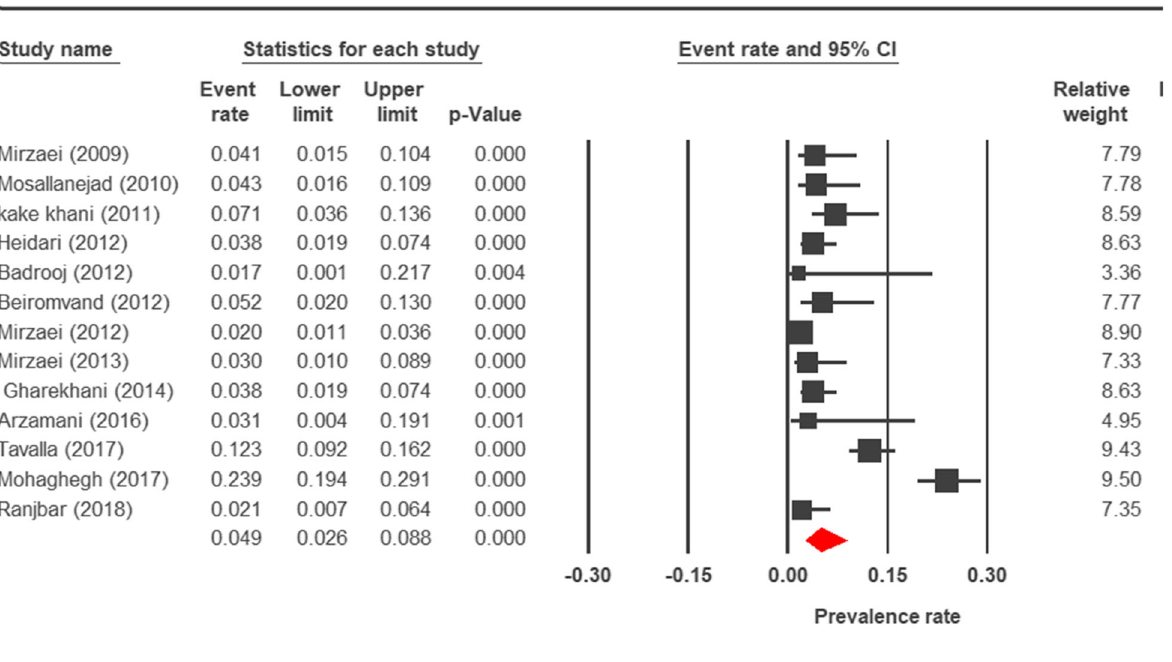
Fig. 6 Forest plot diagram showing the prevalence rate of Cryptosporidium infection in dogs of